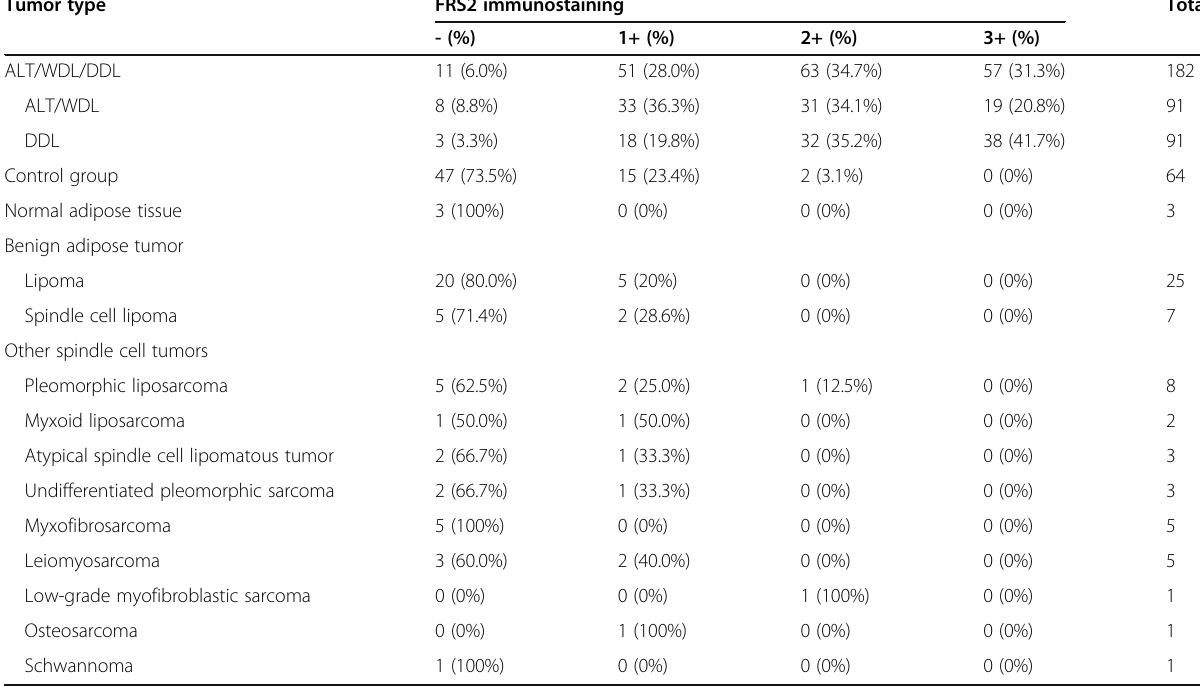
Table 1 FRS2 immunostaining in 182 ALT/WDL/DDLs and 64 control cases Tumor type FRS2